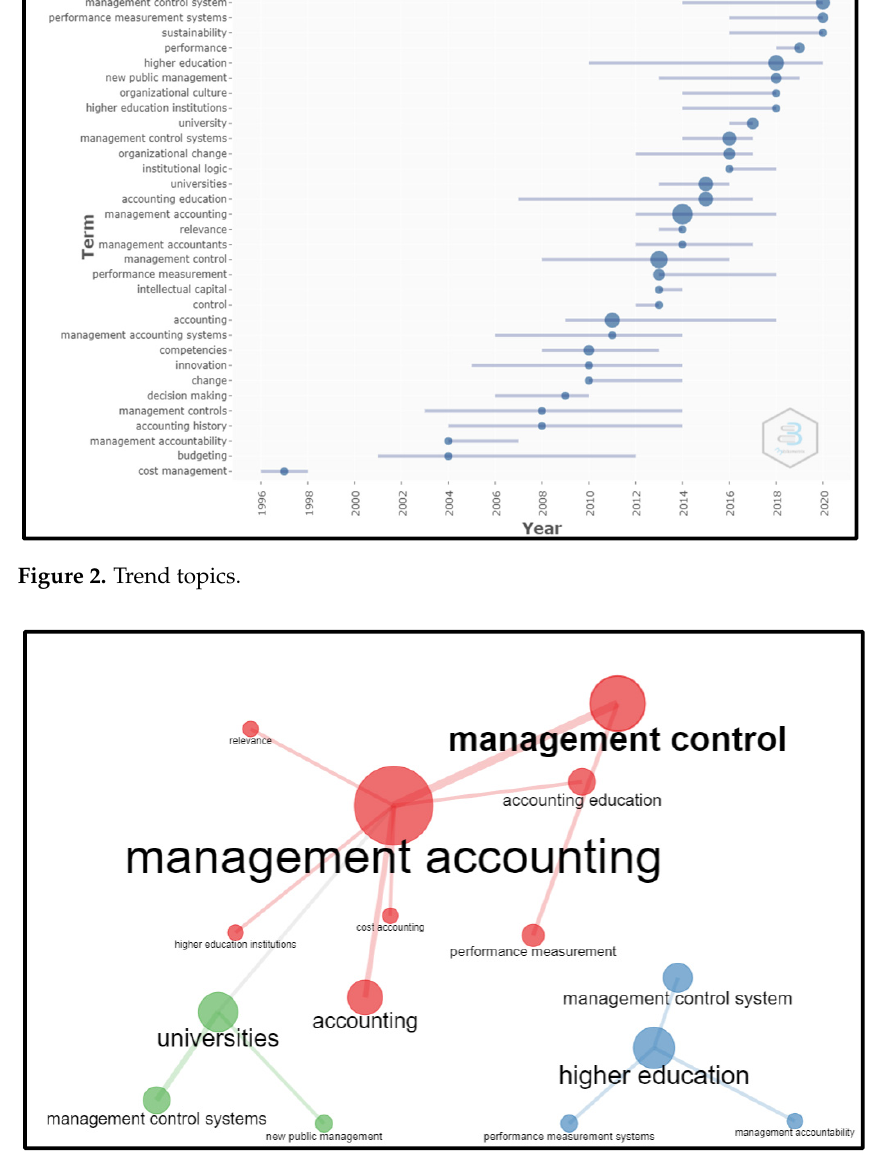
Figure 3. Co-occurrence networks. Longitudinal